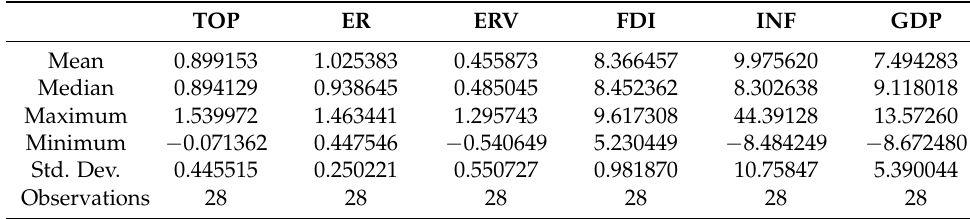
Table 4. Descriptive analysis result.